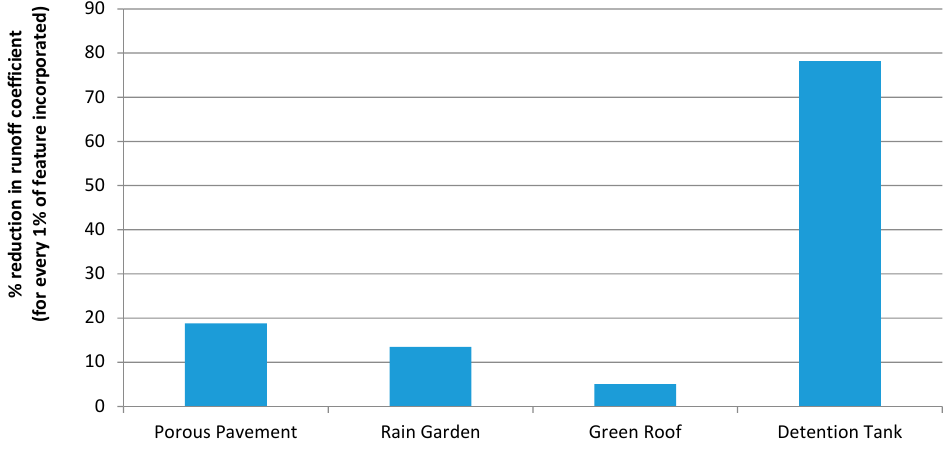
Figure 15. Reduction in runoff coefficient vs. amount of features incorporated.